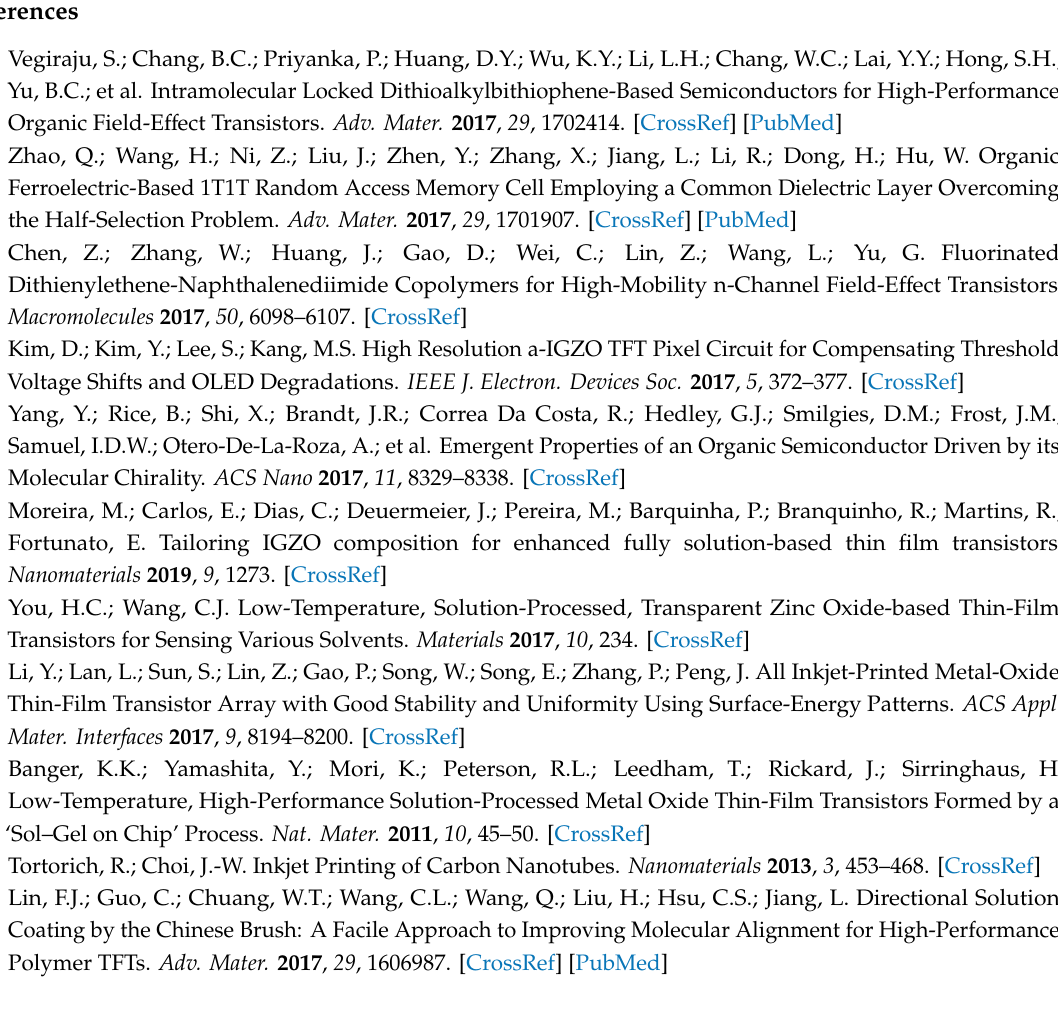
Figure S1: The optical microscope (OM) images of each single ZnO channel width by an IJP droplet with the substrate temperature. Table S1: Thechannel widthsof each ZnOdropletwith di ff erenttemperature. Figure S2: The typical transfer characteristics of I DS -V GS , where I DS was measured while V GS was scanned from -20 V up to 20 V at a constant V DS of 5 V with the substrate temperature. Figure S3: The ring-like channel wire widths depositing e ff ect and the semiconductor within conduction carrier flowing behaviors. The ZnO solution inkjet droplets deposited onto the Si 3 N 4 dielectric layer at di ff erent substrate temperature. Figure S4: The XPS spectra of the Zn 2p 3 / 2 and Zn 2p 1 / 2 components were centered at ~1021.4 and ~1044.5 eV of ZnO films with / without oxygen plasma treatment. Figure S5: The photograph of the ZnO-based photodetector on a semiconductor measuring the load under the Halogen lamp illumination. Figure S6: The electrical characteristics under the Halogen lamp illumination. Figure S7: Current versus voltage ( I-V ) curves of the ZnO-based optoelectronic under light illumination and with the light turned o ff . Figure S8: The SEM image of the transparent ZnO channel layer region, where AuNPs are linked at the interface between the ZnO and dielectric layer by 3-mercaptopropyltrimeth-oxysilane (MPTMS). Figure S9: The UV-vis absorption spectrum of AuNPs